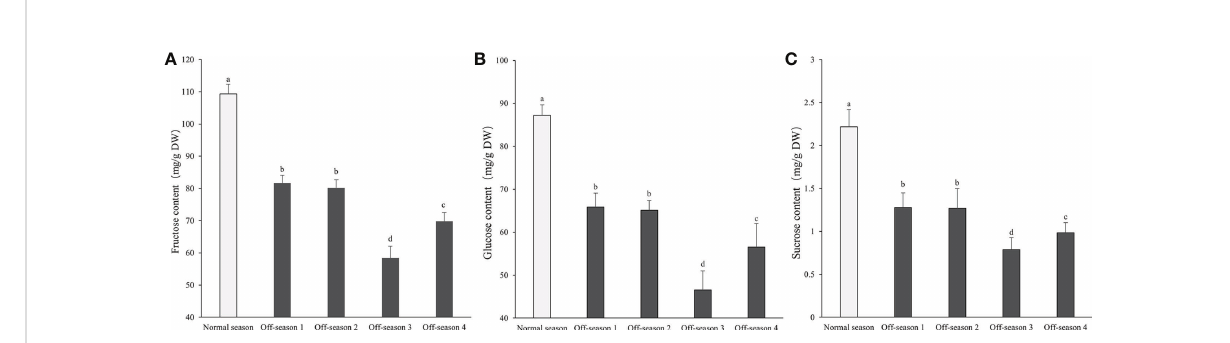
FIGURE 6 Contents of fructose, glucose, and sucrose in differential groups ’ mulberry fruits. (A) Fructose content, (B) glucose content, (C) sucrose content. Within a panel, bars labeled with different lowercase letters differ signi fi cantly ( P< 0.05).